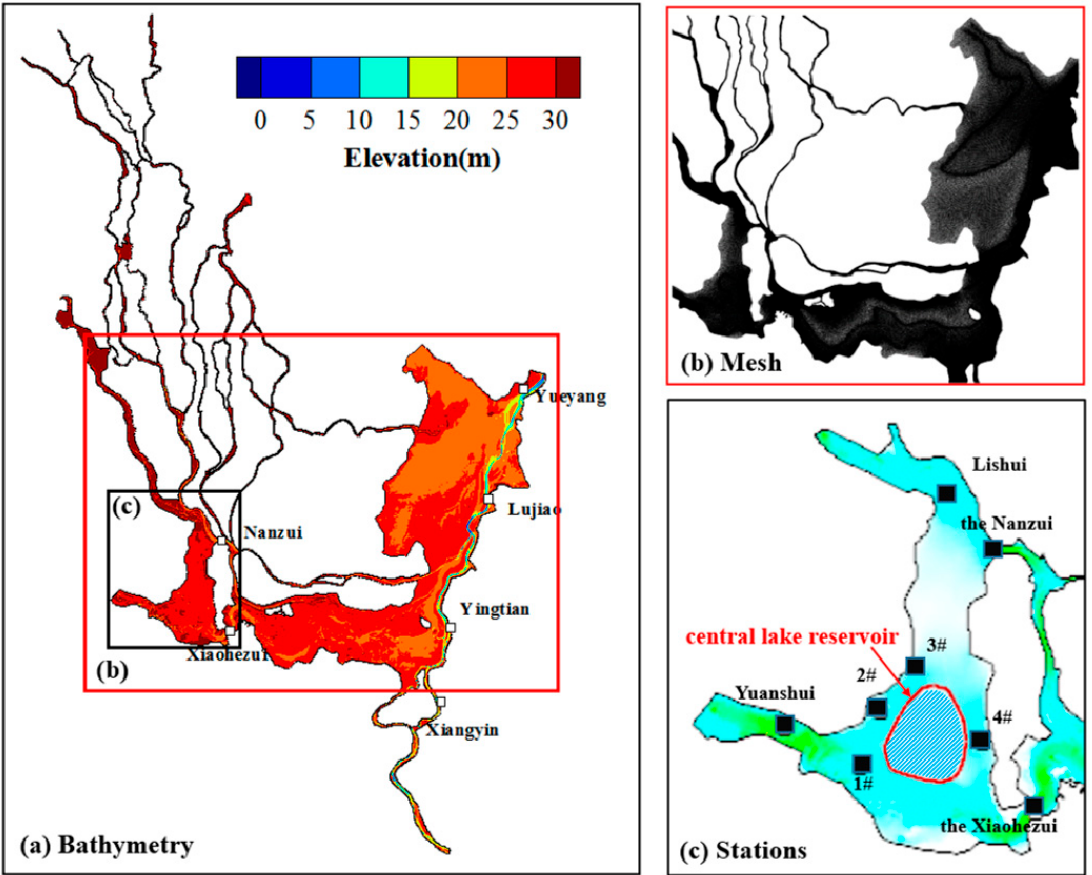
Figure 1. ( a ) The bathymetry distribution of Dongting Lake District; ( b ) Layout of computational mesh; ( c ) Distribution of stations (filled black squares).